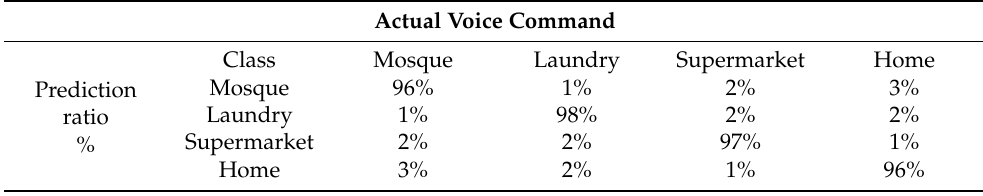
Table 3. Normalized confusion matrix.